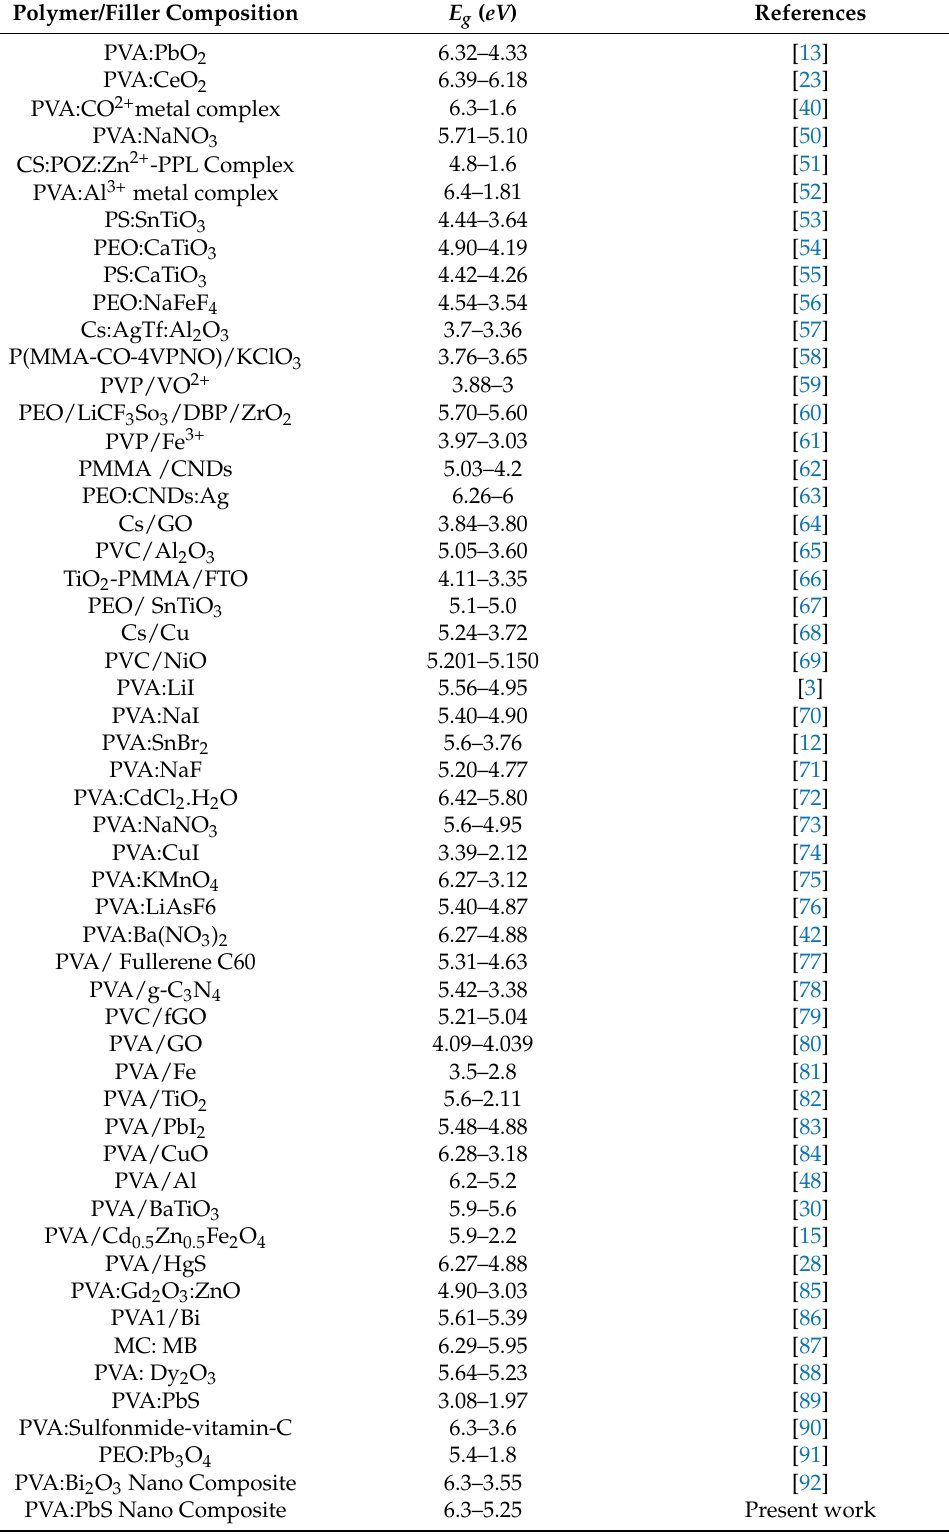
Table 4. E g associated with various polymer compositesin the